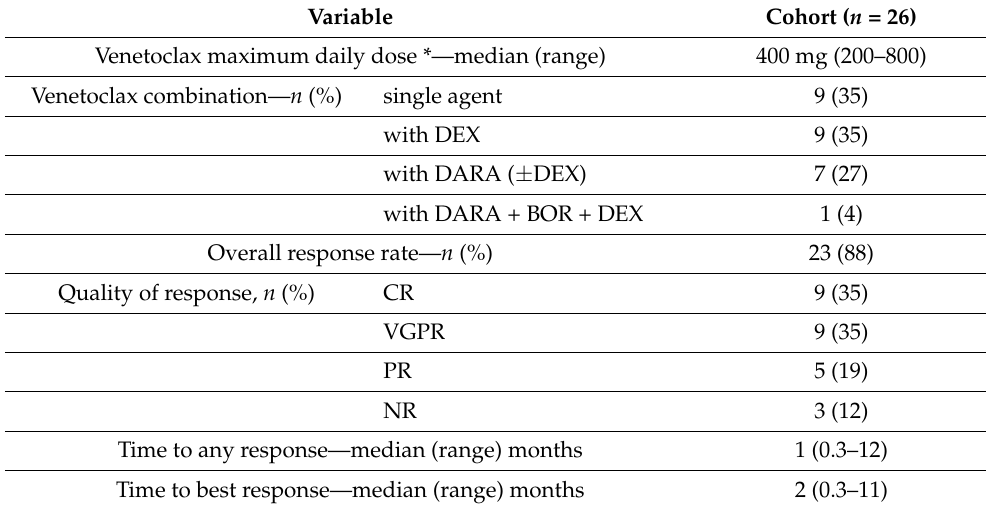
Table 2. Venetoclax treatment—characteristics and response. Variable Cohort ( n = 26) Venetoclax maximum daily dose *—median (range) 400 mg (200–800) Venetoclax combination— n (%) single